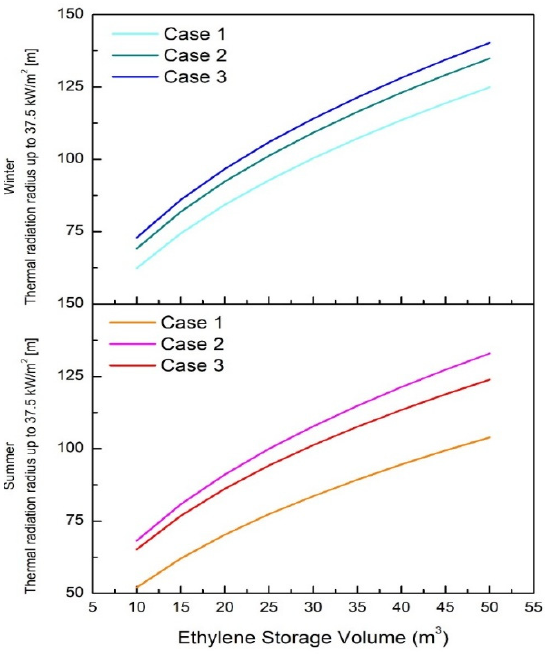
Figure 3. Thermal radiation radius up to 37.5 kW/m 2 according to ethylene storage capacity in summer (40 °C) and winter (0 °C) conditions.